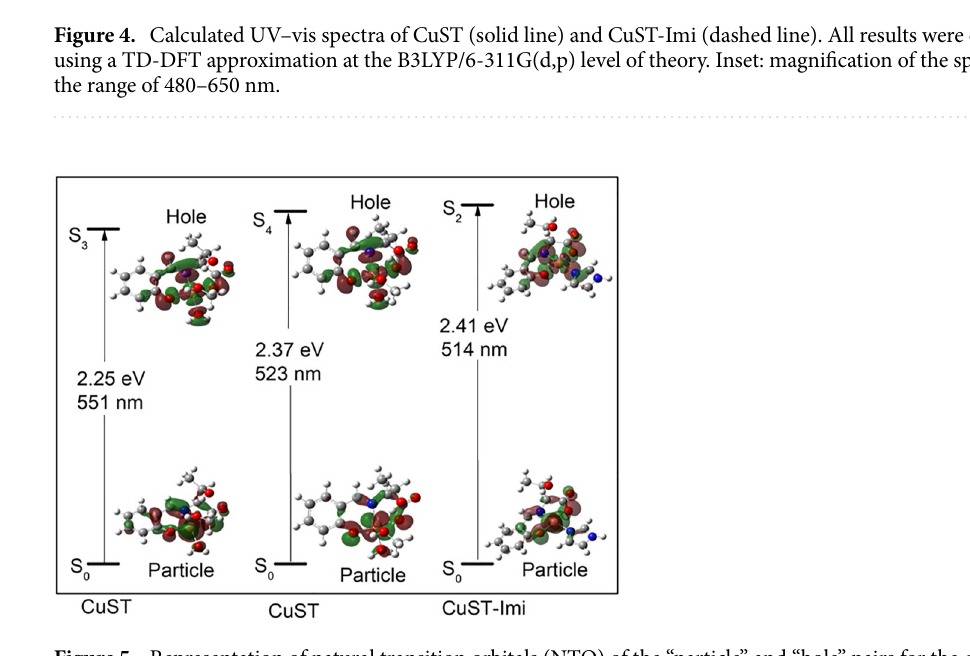
Figure 5. Representation of natural transition orbitals (NTO) of the “particle” and “hole” pairs for the d–d bands of CuST and CuST-Imi. The NTO pairs occupy more than 1.97 of each excited state (isodensity contour